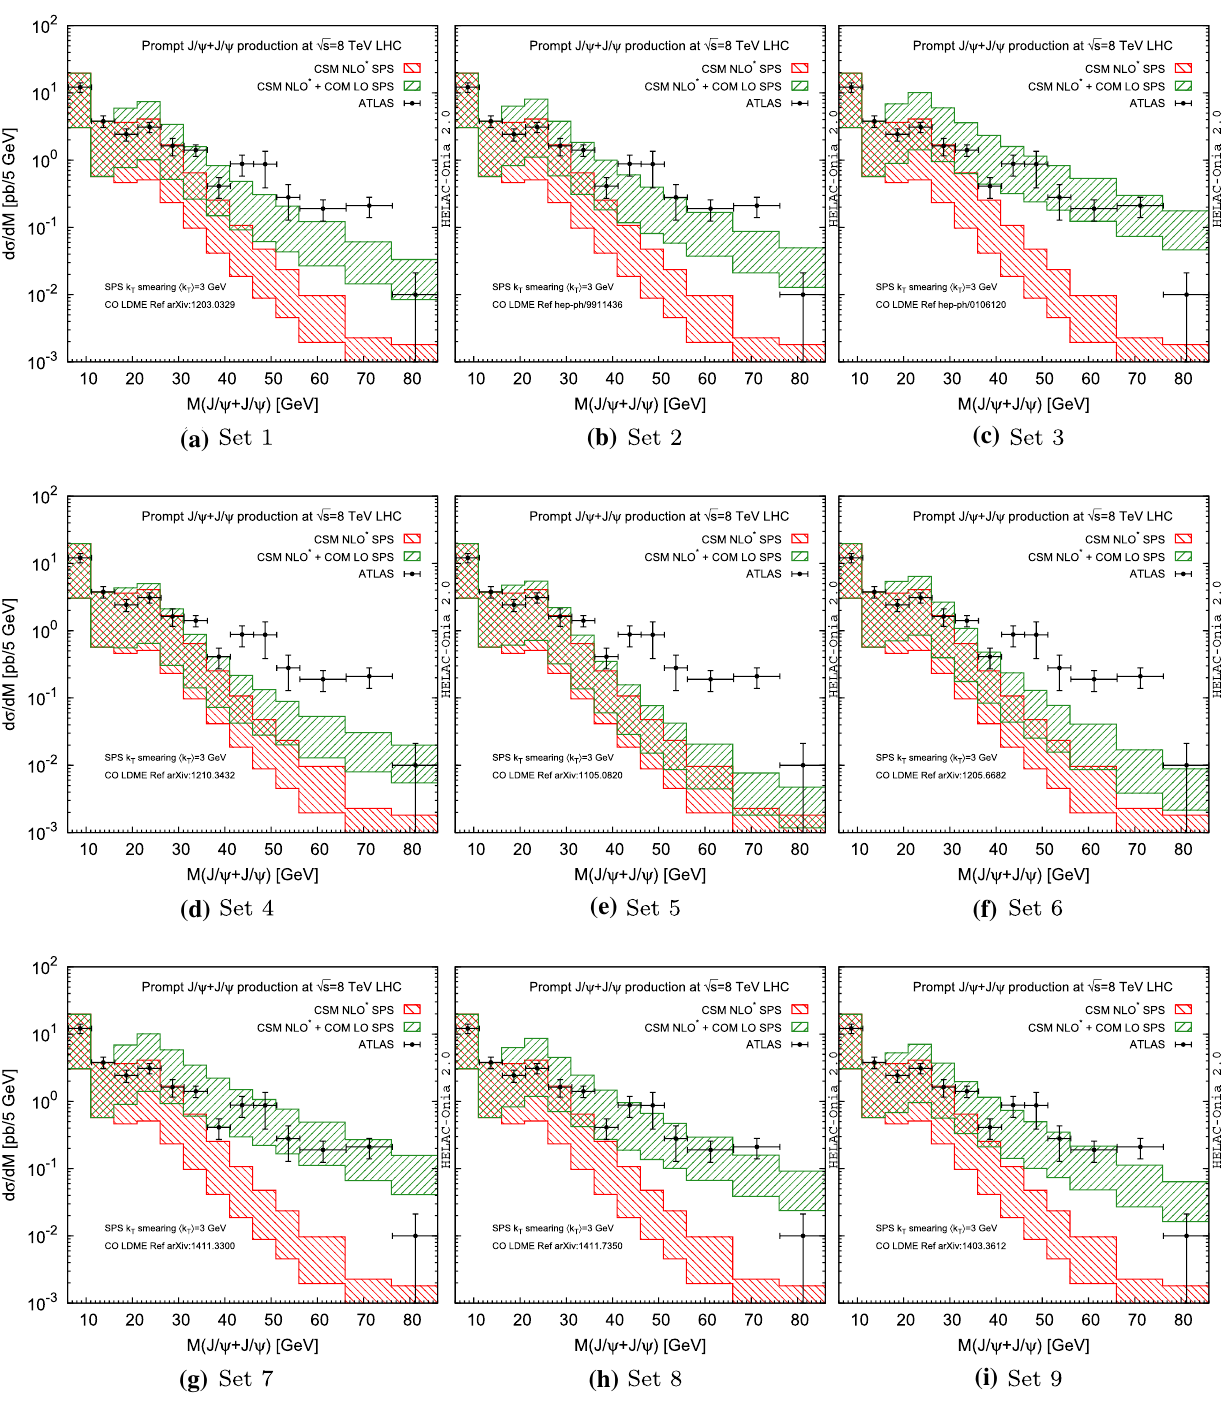
√ s = 8 TeV acceptance [22]